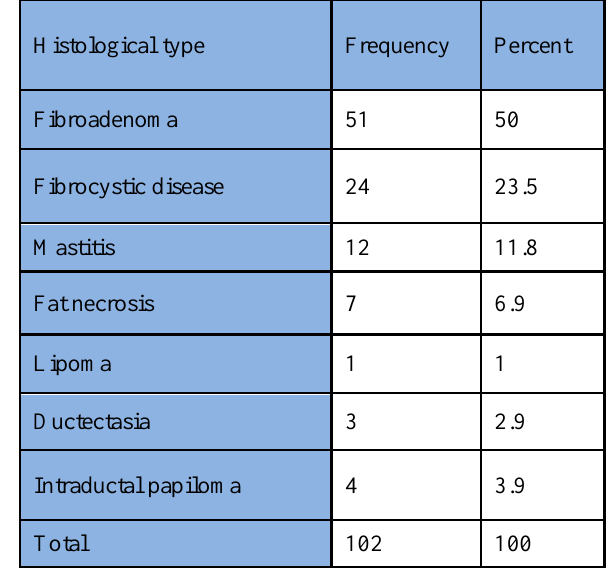
Table 4 The histological types of diagnosed malignant beast diseases Histological type